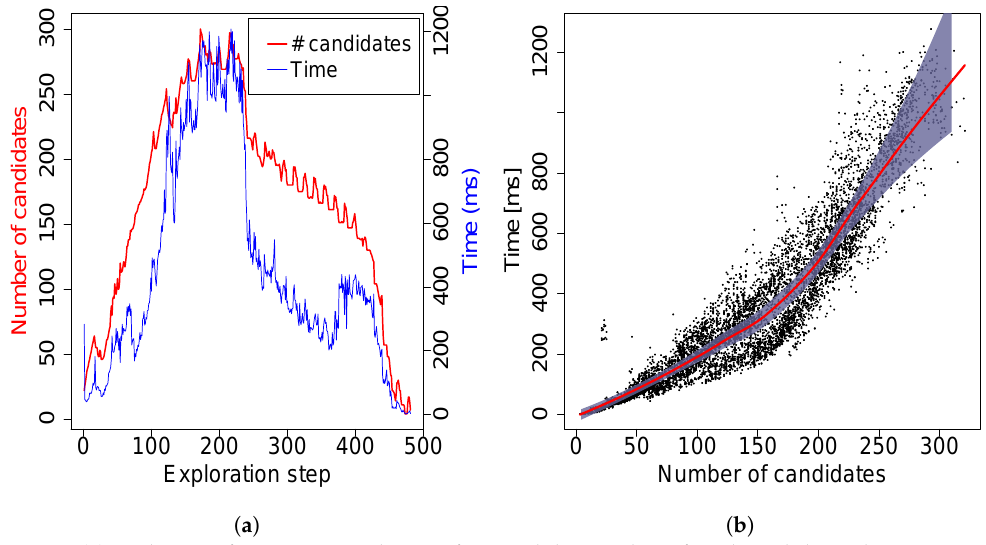
Figure 10. ( a ) evolution of computational time of EA and the number of goal candidates during a typical run on jari-huge with ρ = 1.5 m; ( b ) dependency of computational time of EA on a number of candidates. The dots represent measurements from 15 runs on jari-huge with ρ = 1.5 m. The red curve is a smoothed computational time averaged over the number of candidates, while the grey area represents the confidence interval computed for mean on a 95% confidence